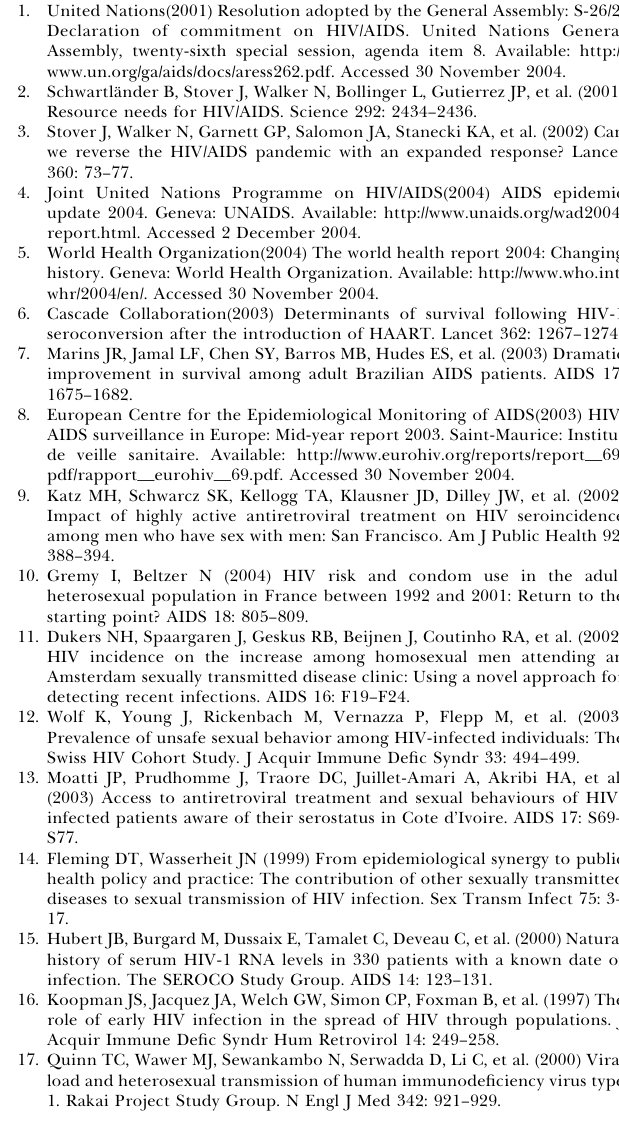
Figure S1. Adults Living with HIV/AIDS in Sub-Saharan Africa, 2003–2020, under Different Intervention Scenarios Found at DOI: 10.1371/journal.pmed.0020016.sg001 (80 KB EPS). Protocol S1. Technical